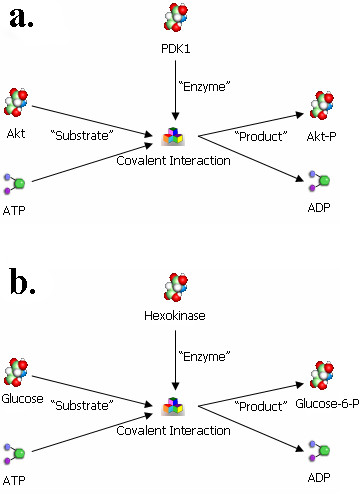
A model for covalent interactions. Figure 4a shows that an Akt protein can be phosphorylated to an Akt-phosphate by an enzyme, PDK1, and an ATP is converted to an ADP in the process. Figure 4b shows a similar covalent interaction event where substrate Glucose can be converted to Glucose-6-phosphate by an enzyme Hexokinase.